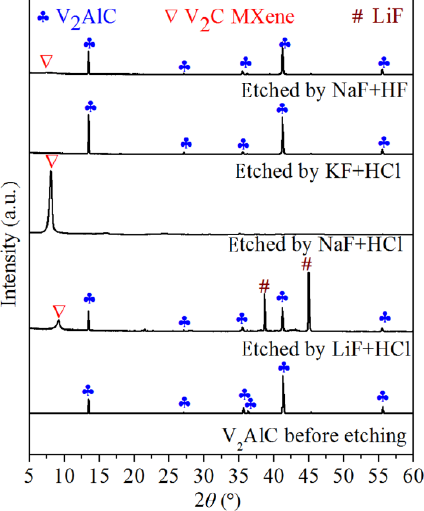
Fig. 13 XRD patterns of V 2 AlC samples before and after the etching in different solutions. Reproduced with permission from Ref. [117], © The Author(s)